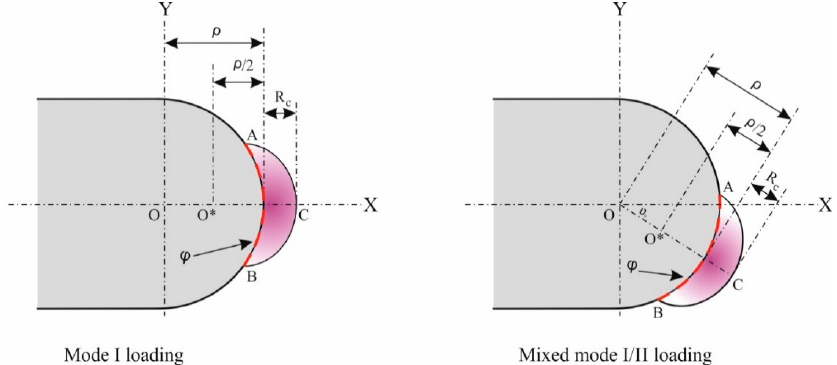
Figure 8. Material dependent control volume for a U-notch under mode I ( left ), and mixed mode I/II ( right ) loadings.